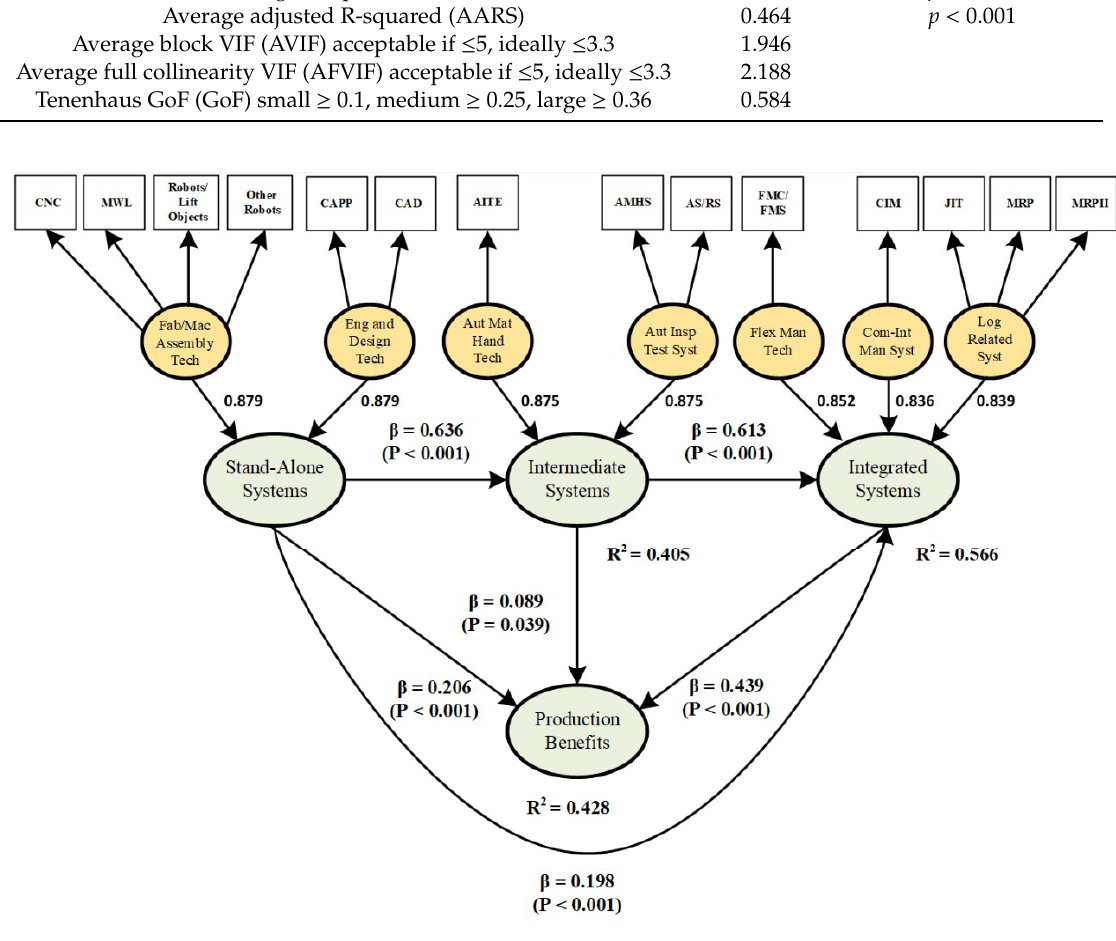
Table 7. Conclusions of the hypotheses.